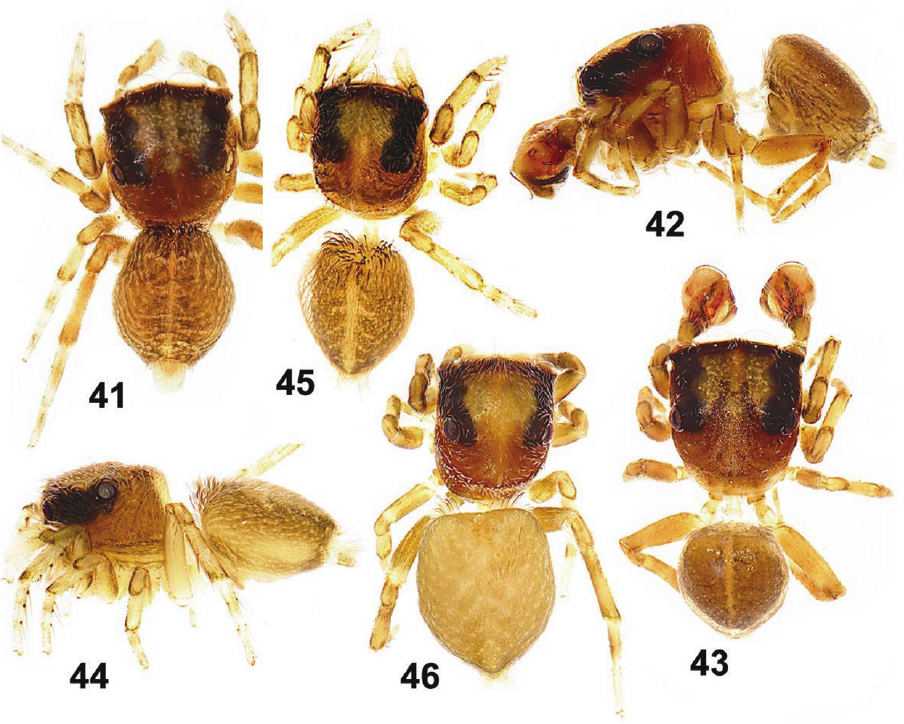
Figures 41–46. General appearance of Eupoa lehtineni sp. n. 41 , 45–46 females, dorsal view 42 male, lateral view 43 ditto, dorsal view 44 female, lateral view. Specimens: 41–43 – India; 44–46 –